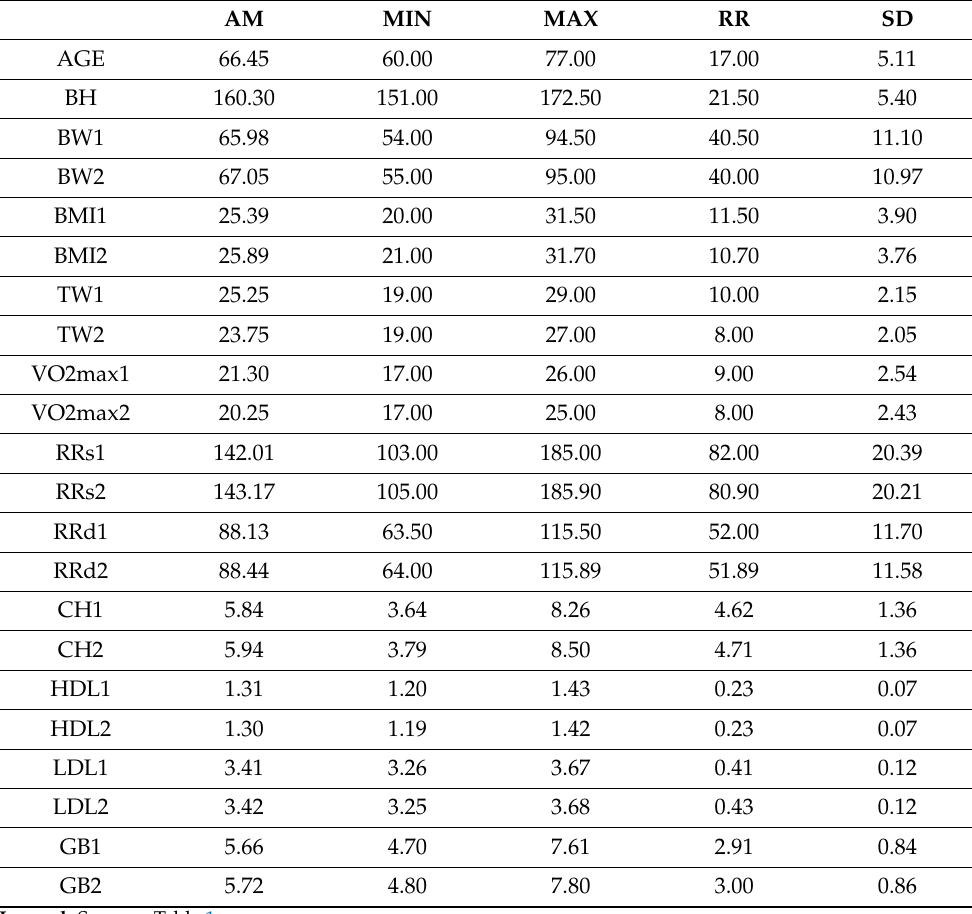
Table 3. Descriptive parameters of the control group (initial and final).